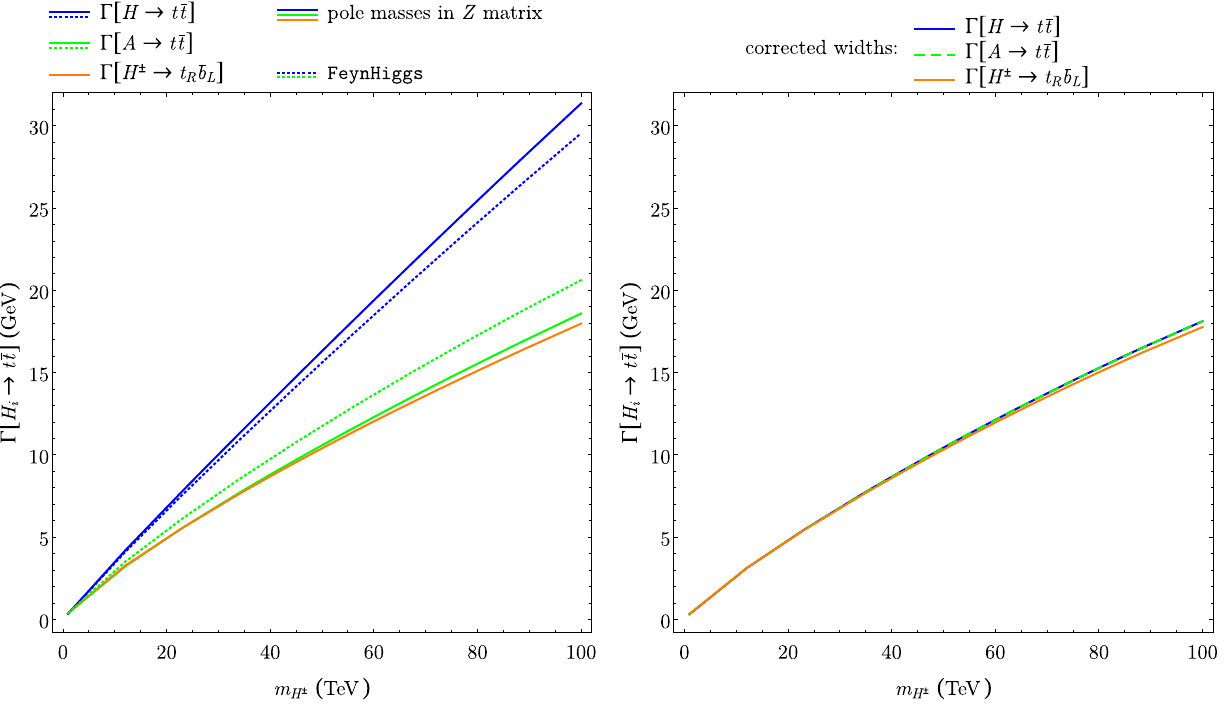
our knowledge, the corresponding order is not available for the charged Higgs. Differences with our results (solid lines) originate in several higher-order pieces (as we checked): mixing matrix vs. LSZ, inclusion of a vertex 2 term in FeynHiggs , resummation of Sudakov double logarithms in our case. Right: Mixing and vertex contributions all con- sistently employ Yukawa couplings including the